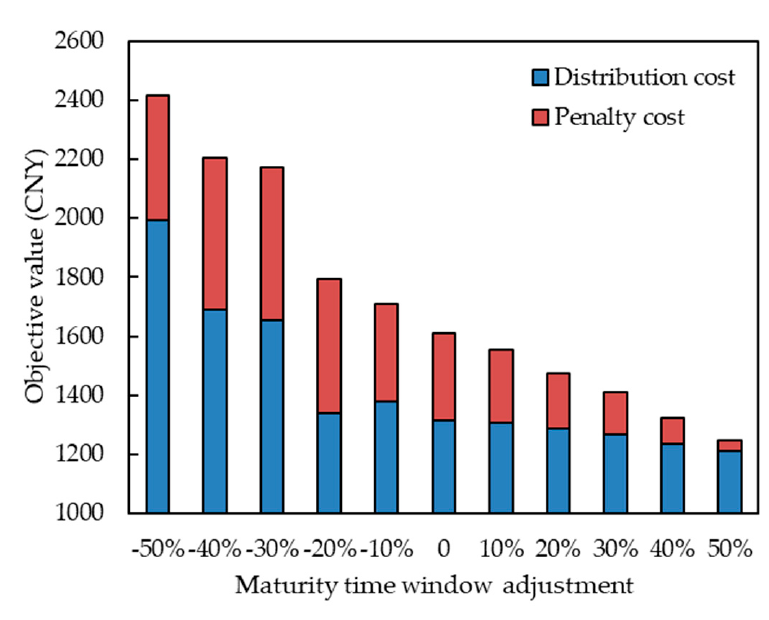
Figure 9. Relationship between the time window and the objective value.